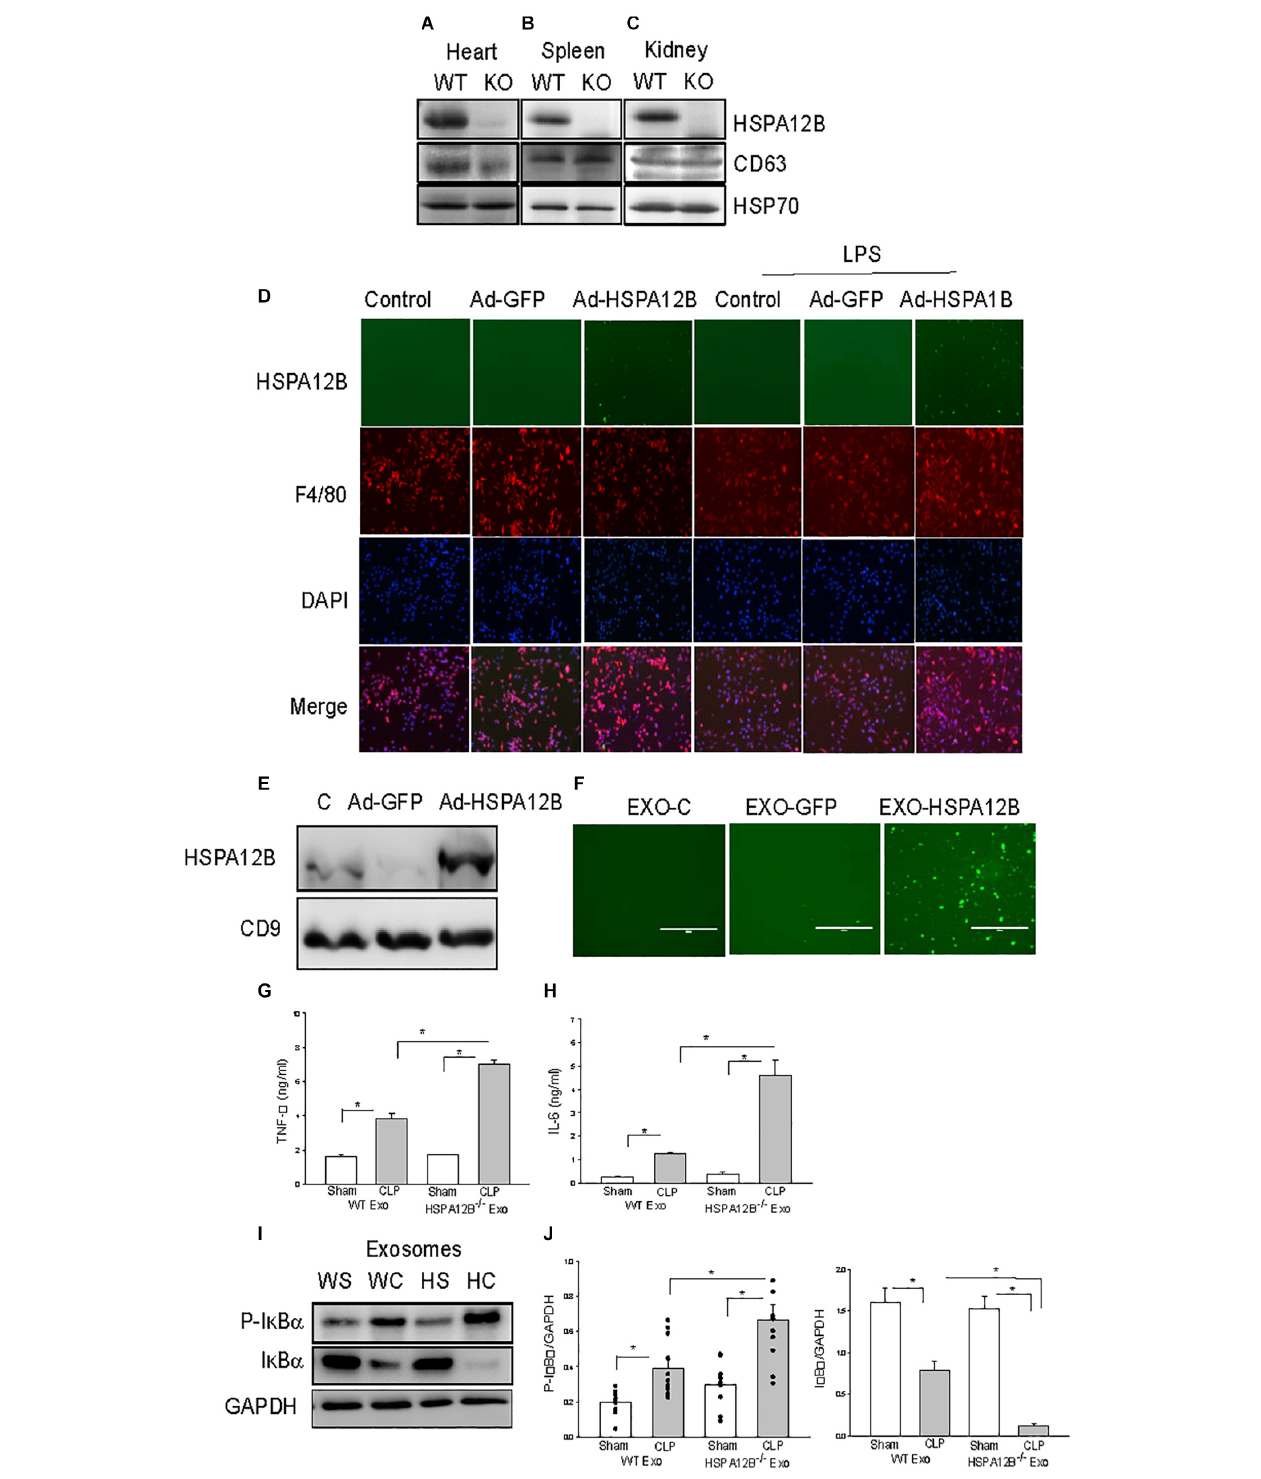
FIGURE 4 | Macrophages uptake endothelial exosomes that contain HSPA12B. (A–C) Exosomes were isolated from heart (A) , spleen (B) , and kidney (C) of WT and HSPA12B − / − mice. (D) Macrophages uptake endothelial HSPA12B from endothelial cell conditioned medium. HUVECs were transfected with Ad-HSPA12B-GFP or Ad-GFP. Twenty-four hours after transfection, the cultured medium were collected as the endothelial conditioned medium (ECM). Macrophages (Raw 264.7) were